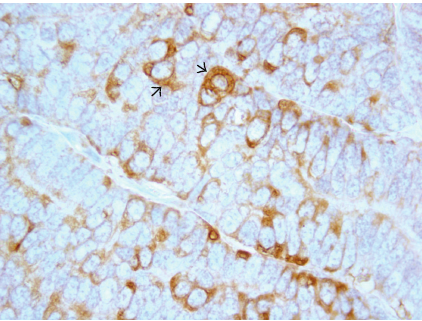
Figure 4: Figure 4: Dog. Mammary tumor. Cytoplasmic positivity (arrow) in carcinoma cells. Anti-VEGF immunohistochemistry